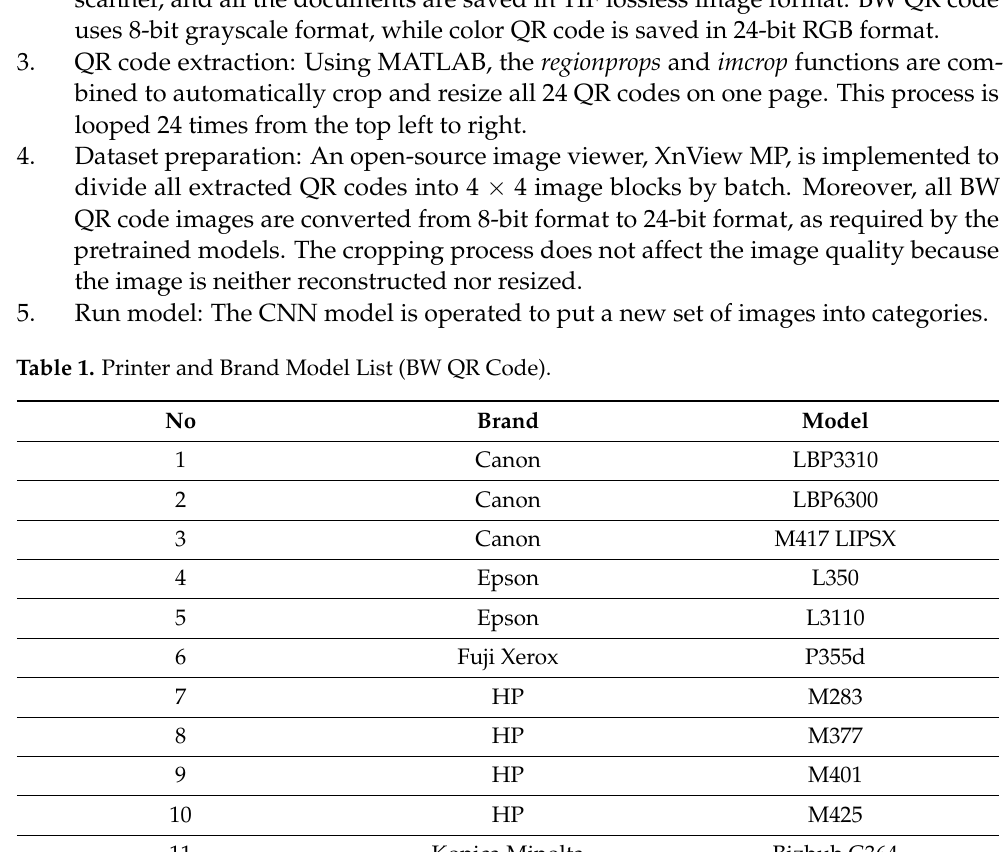
Table 1. Printer and Brand Model List (BW QR Code).